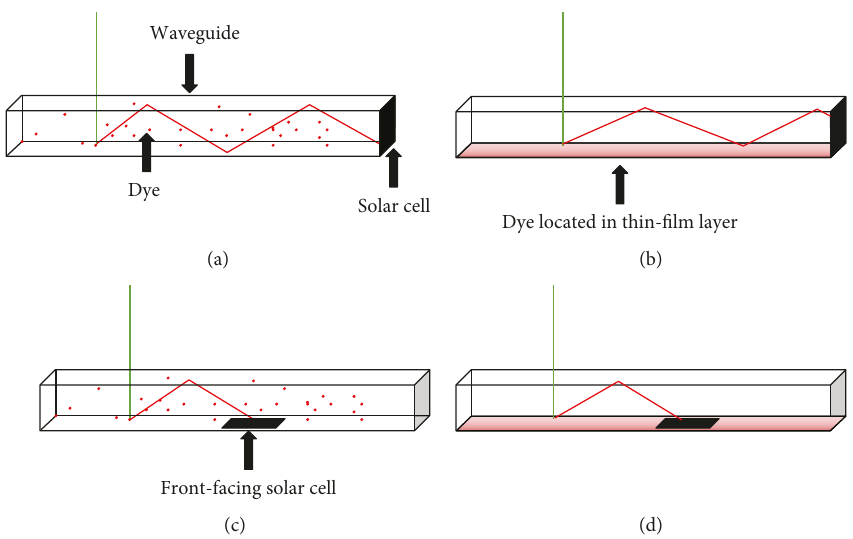
Figure 1: Conventional bulk-doped (a) and thin- fi lm (b) LSC designs utilizing edge-mounted solar cells. Front-facing bulk-doped (c) and thin- fi lm (d) LSC designs. Dye molecules are dispersed throughout the waveguiding material in the bulk-doped device and applied in a concentrated layer to the backside of the thin- fi lm device. Both designs rely on total internal re fl ection in the waveguide to concentrate